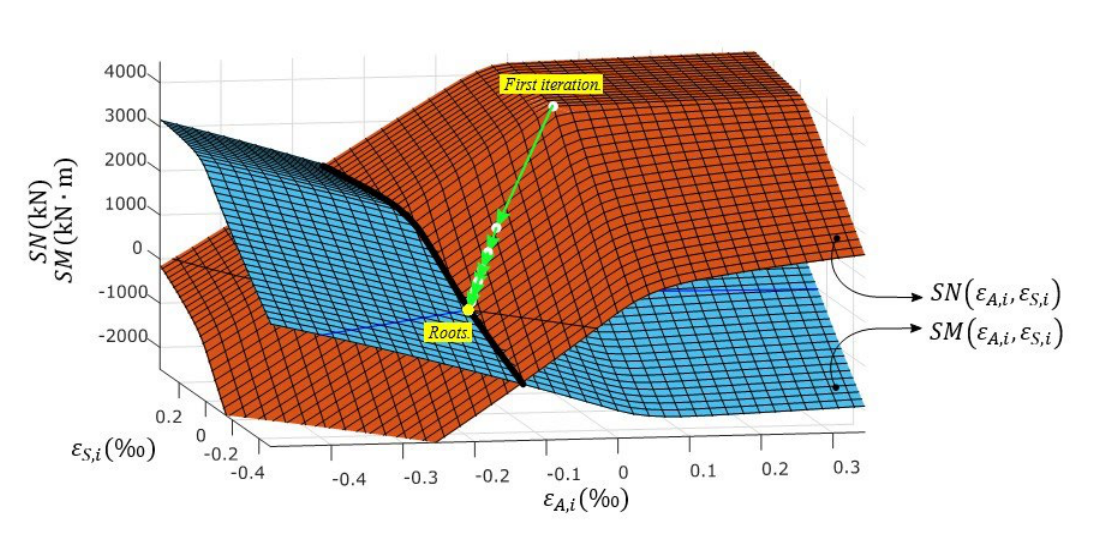
Figure 7. Problem of determination the strains in the initial